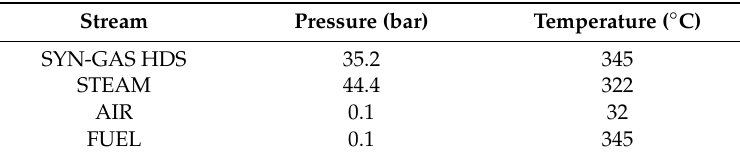
Table 1. Inlet stream conditions in Section 1.